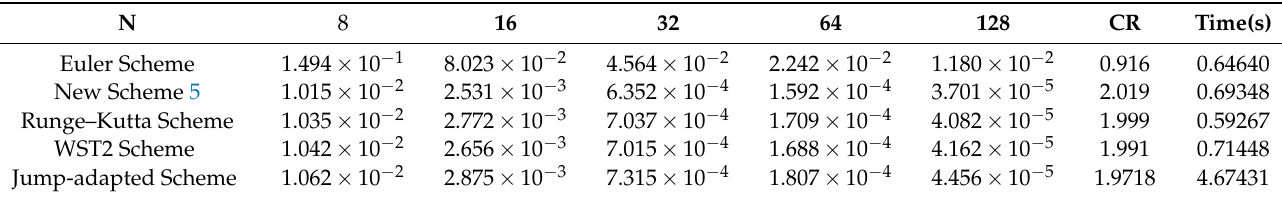
Table 2. Errors and convergence rates of schemes with the parameters of Example